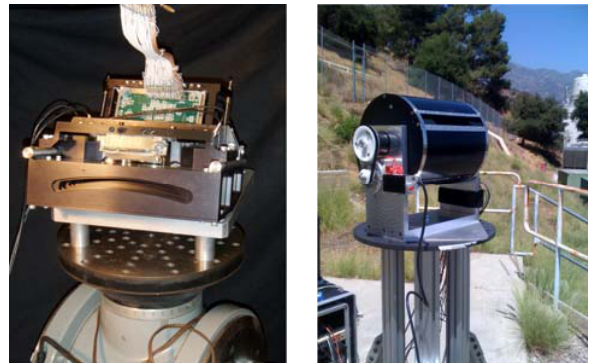
Figure 3. The Ground-based Multiangle SpectroPolarimetric Imager (GroundMSPI) camera ( left ) is mounted in a rotating drum ( right ) to provide pushbroom imagery of